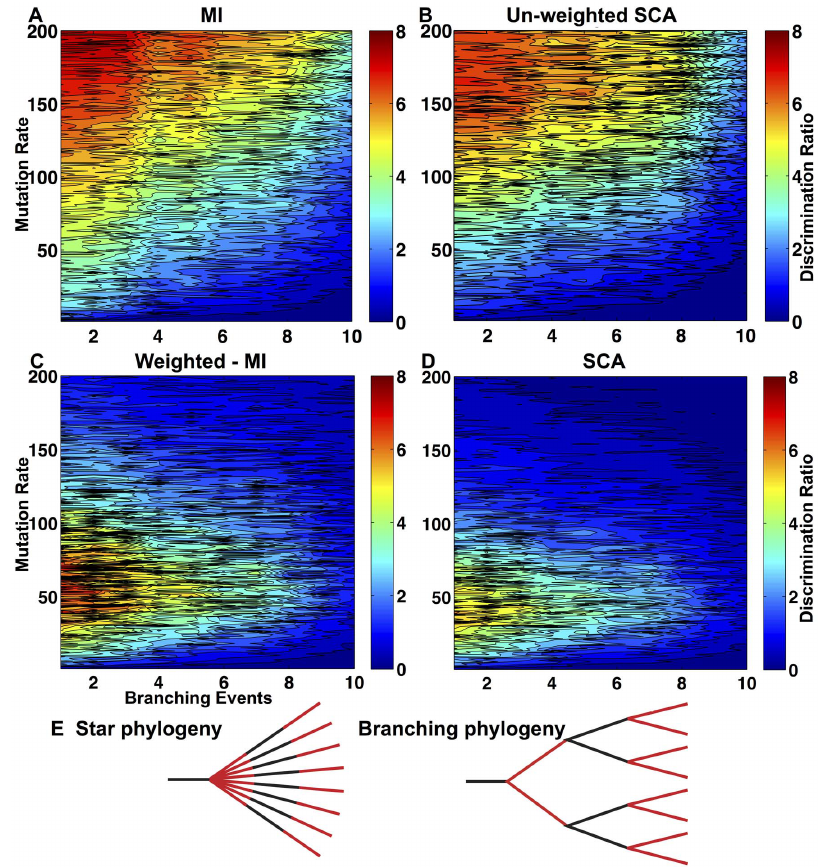
Figure 3. Comparison of algorithm performance on simulations of molecular evolution where 10 residue pairs are correlated while 80 residues mutate independently. (A) The MI algorithm, consisting of weighting function w var and MI consisting of weighting function w var and SCA